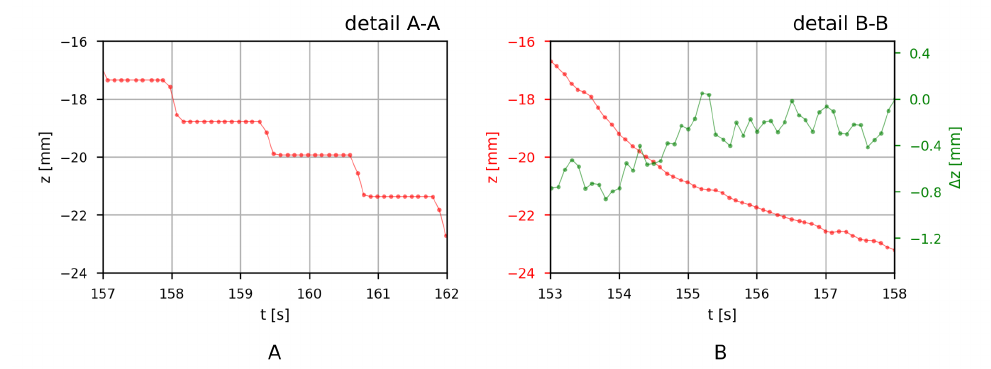
Figure 11. Translation (red) of the robot’s end effector in the vertical direction (i.e., Z-axis) ( A ) for detail A-A in Figure 10 when the operator is manually controlling the robot with a teach pendant and ( B ) for detail B-B in Figure 10 when the operator is manually controlling the robot with the developed IMU system. Input (green) for the robot from the developed IMU system is a change in position ∆ z